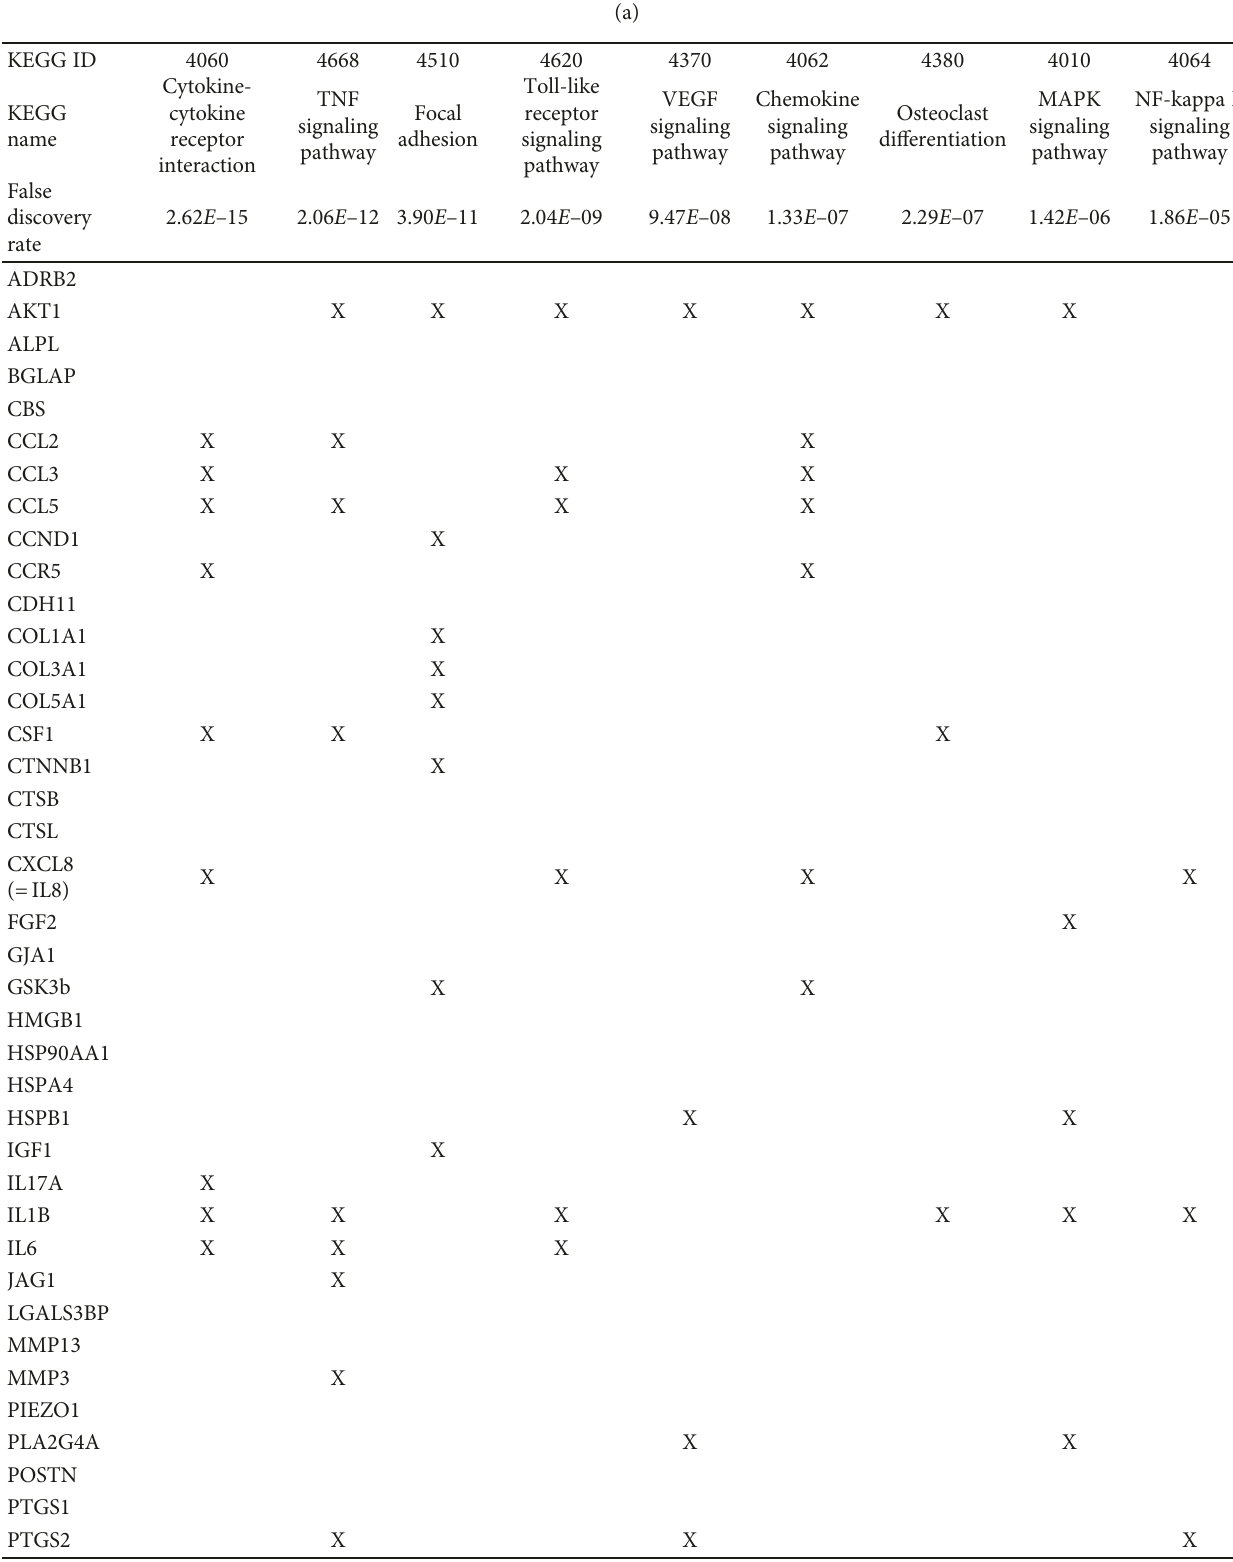
Table 2: KEGG pathways relevant for OTM with false discovery rates below 1.00 E − 05 derived from STRING analysis using the set of examined genes from human periodontal ligament cells ( “ hPDLC list ” ; top panel) and human bone and bone-related cells and cell lines ( “ hOB list ” ; bottom panel). “ X ” , gene involved in that speci fi c